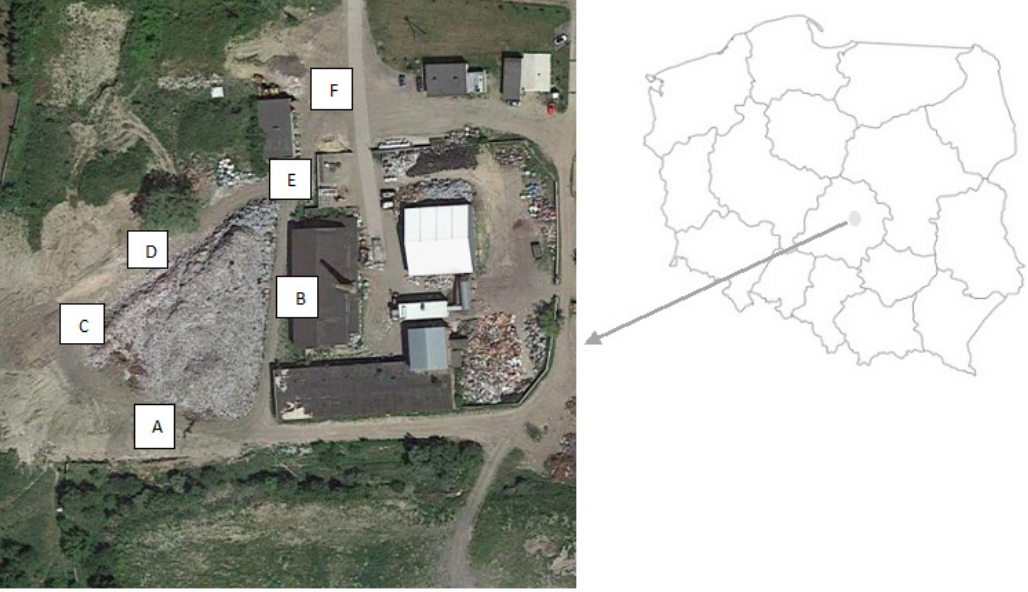
Figure 1. Tested landfill with an indication of the sampling sites.